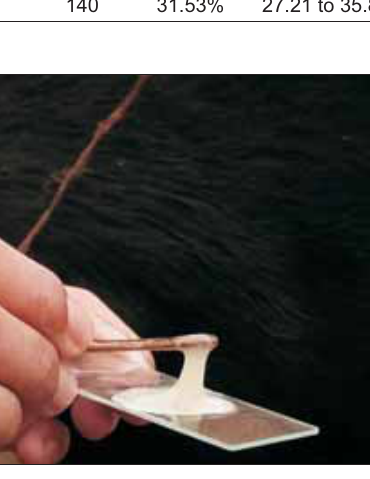
Figure-1 (c): Positive Surf Field Mastitis Test (Background is whey like with clumps of coagulated